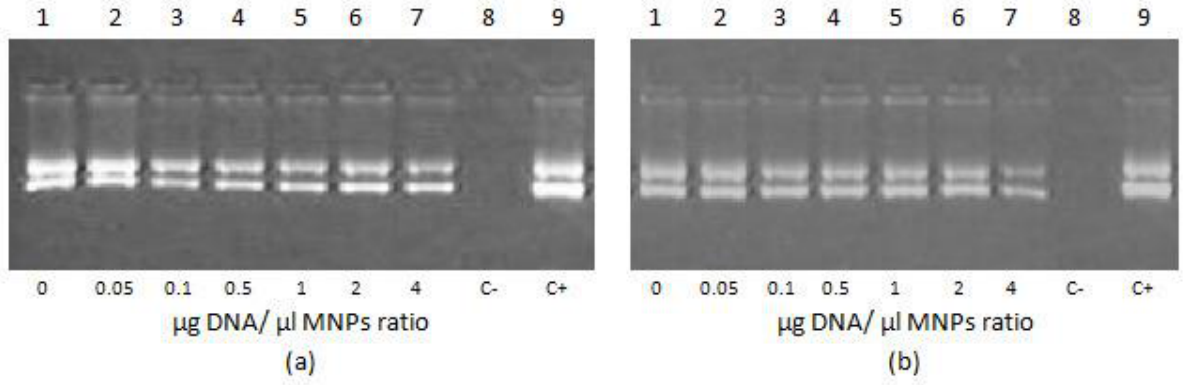
Figure 2. Efficiency of DNA protection from nuclease degradation within R6p-cRGD/DNA/MNPs polyplexes after DNase I enzyme digestion. The polyplexes containing 0.5 µg of DNA were treated with 0.2 units of DNase I for 30 min at 37 ° C. C− is DNA treated with DNase I; C+ is intact DNA. ( a ) R6p-cRGD/DNA N/P ratio is of 8/1; ( b ) R6p-cRGD/DNA N/P ratio is of 12/1.